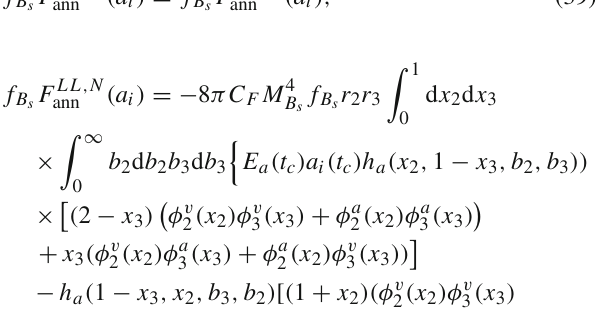
√ s corresponding to central param- 0 ,